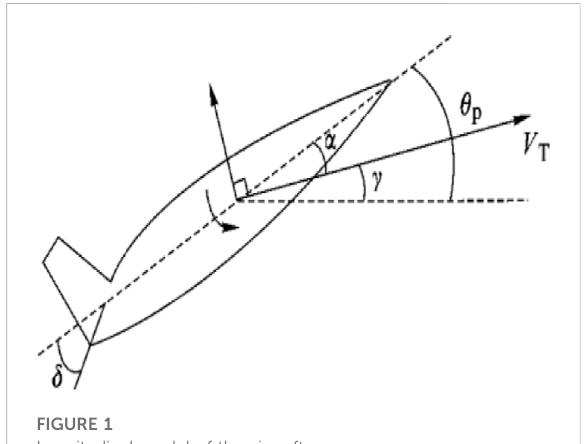
FIGURE 1 Longitudinal model of the